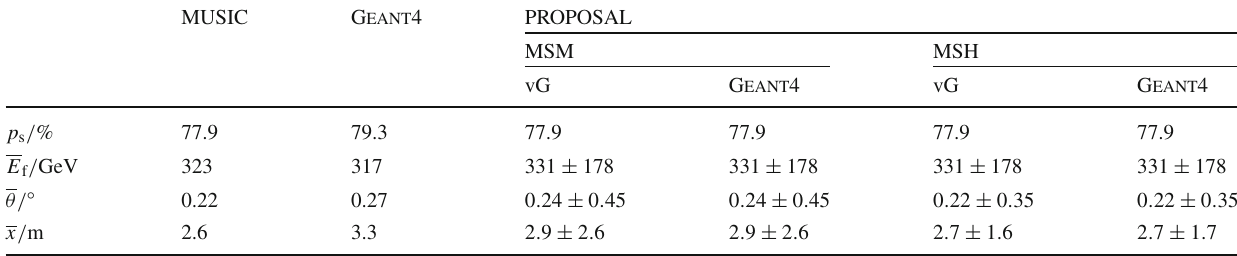
cases. Right: The lateral displacement x in meter depends on the scat- tering method. MSM leads to larger distances. In the zoomed-in figure, the region around the mode of the distributions is presented. The mode of Geant4 is shifted to larger deflections. Detailed information are given in Table 2. The results for MUSIC and Geant4 are taken from Ref. [8] displacement x are presented for all cases from Fig. 2. For all means, the standard deviation is given. The largest deflection and displacement is observed in the tool Geant4 , which has the lowest mean survived energy. The lower the energy, the larger the